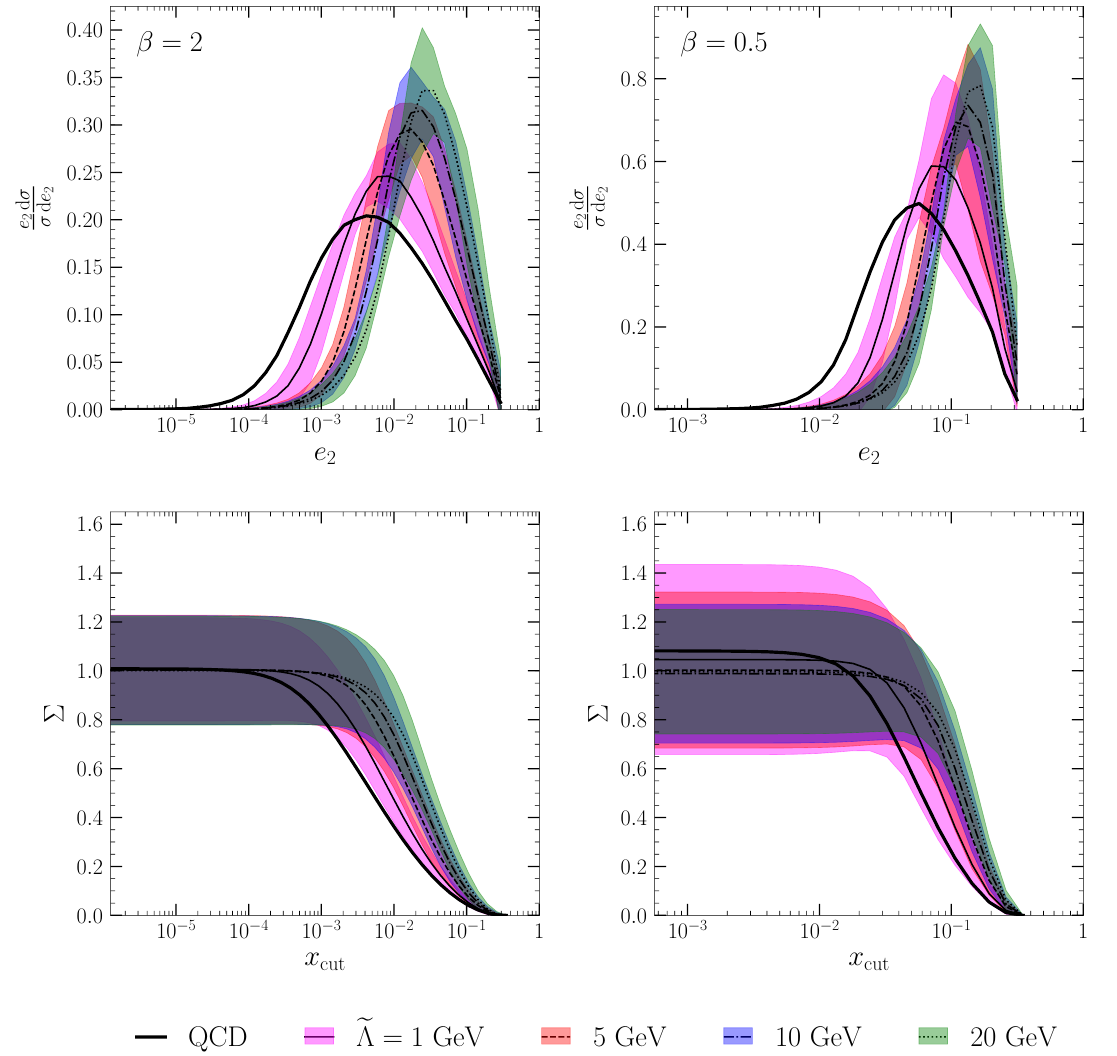
Figure 3 . The behavior of e 2 as the dark confinement scale e (cid:3) is varied, for p T = 1 TeV jets. See the legend for values of e (cid:3) ; all other values are given in table 1. We show the normalized e 2 distributions [top], where the central value of the envelope is marked with the black lines, while the shaded region denotes the envelope. The peak shifts to larger values of e 2 as e (cid:3) is increased. The cumulant distributions (cid:6) as a function of x cut are also provided [bottom], where again the lines denote the central values and the shaded bands are the integrated envelopes, see eq. (2.9). We show both results for two choices of the angular dependence: (cid:12) = 2 [left] and (cid:12) = 0 : 5 [right]. jet. This implies that the peak of the differential distribution occurs at a larger value of e